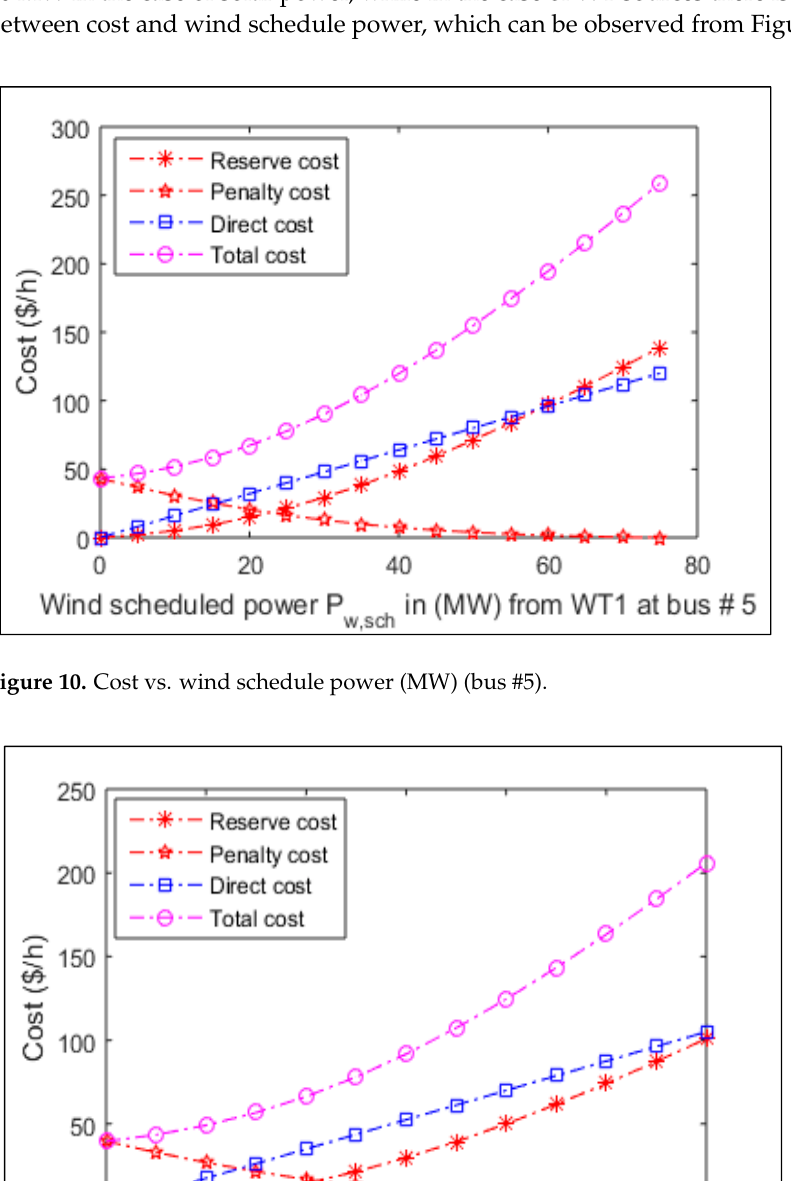
Figure 12. Cost vs. SPV schedule power (MW) (bus#13).